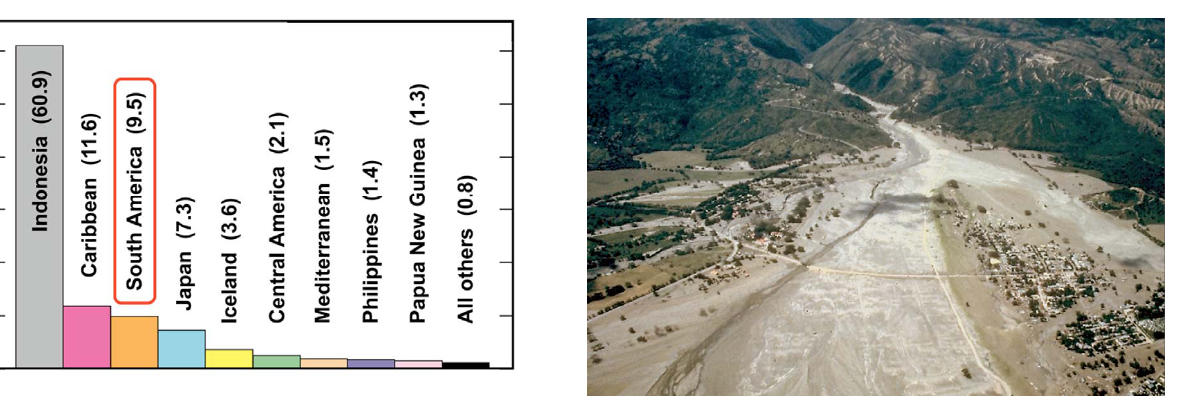
Fig. 9. Histogram of eruption-related deaths worldwide (~ 300,000) since 1600 A.D. grouped according to country or volcanic region. Numbers in parentheses give the percentages of worldwide deaths for each region. South America ranks third in eruption fatalities, which overwhelmingly reflect a single event, the Ruiz volcanic disaster in 1985 (see text). [Primary data source: Simkin and Siebert, 1994.]